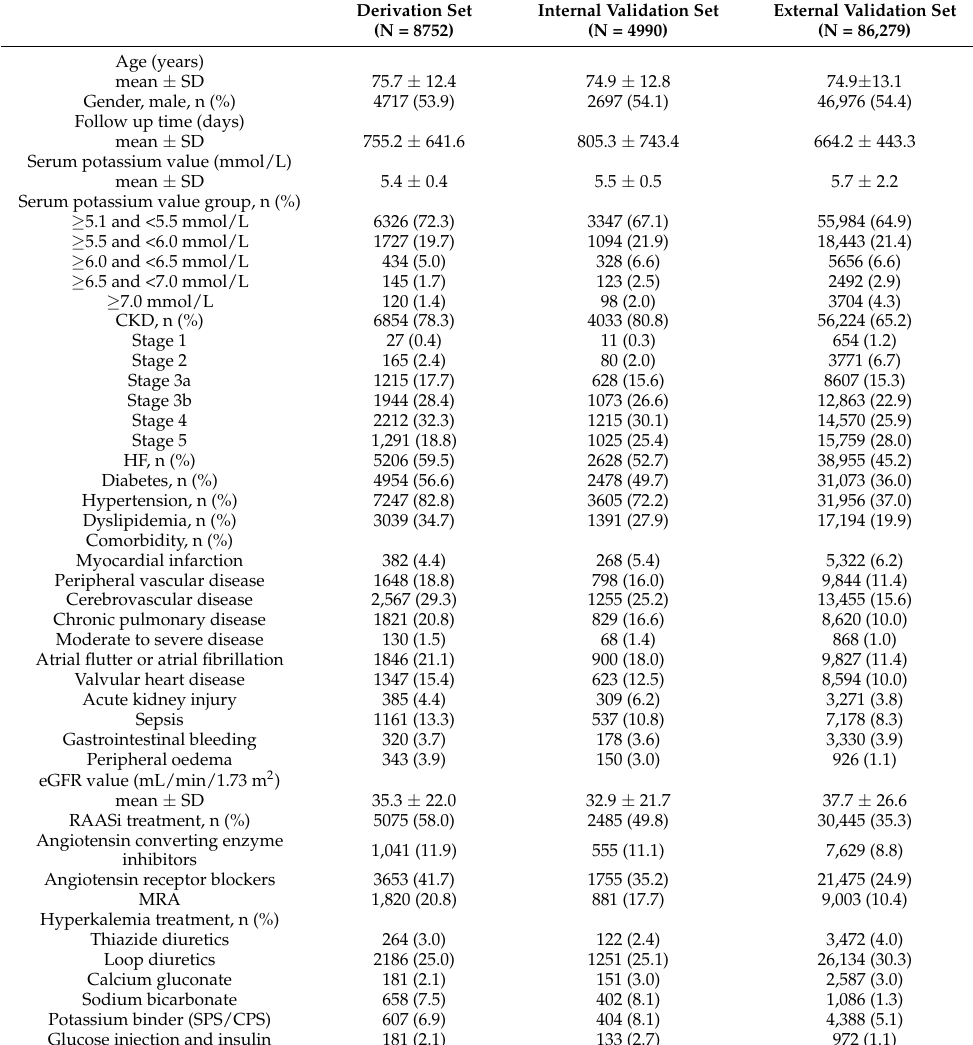
Table 1. Characteristics of patients at the first hyperkalemic episode in the derivation, internal validation, and external validation